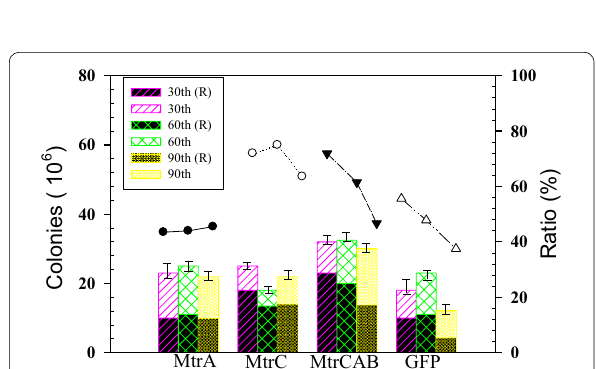
Fig. 5 Plasmid stability analysis for MtrA, MtrC, MtrCAB and GFP in terms of colonies shown in black bar for culture in antibiotics, white stack‑bar for culture without antibiotics (left Y ‑axis), and the ratio (right Y ‑axis) of (black circle) MtrA, (open circle) MtrC, (black diamond) MtrCAB and (open diamond)